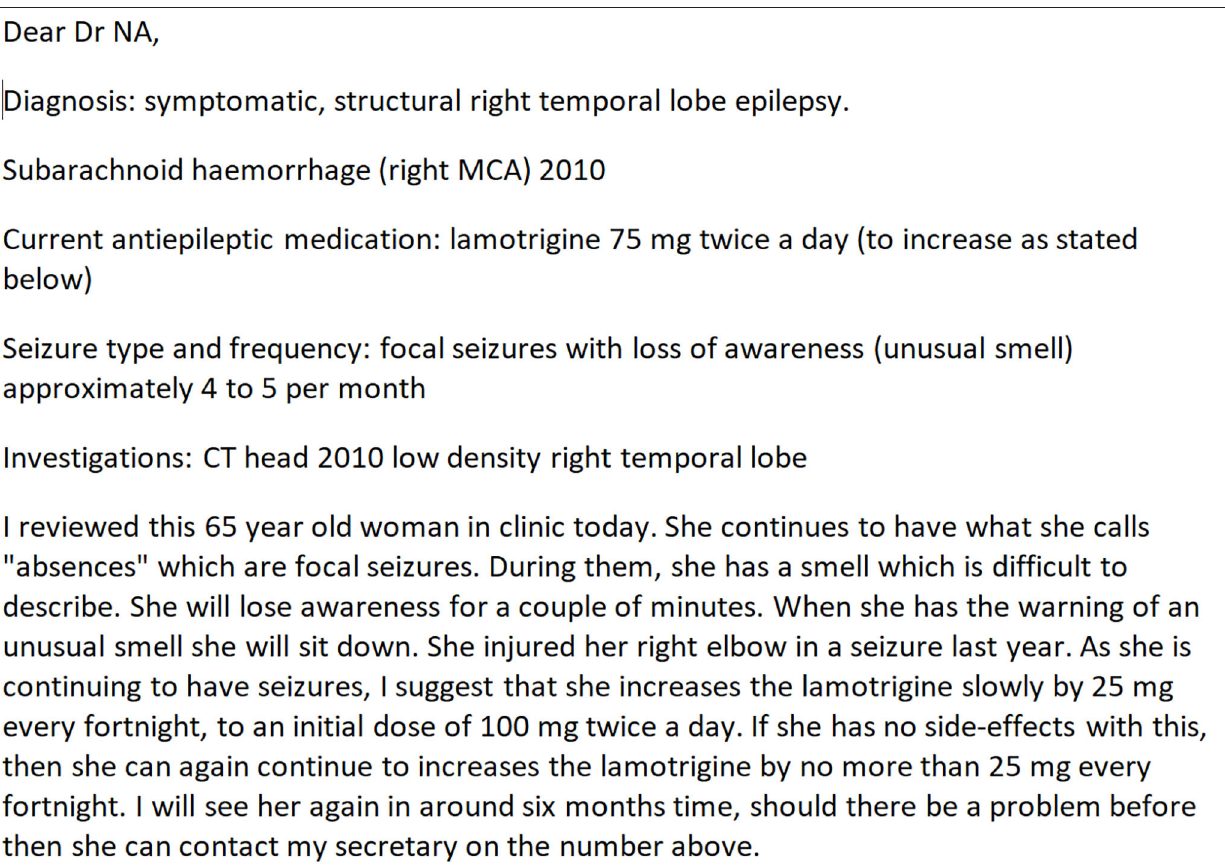
FIGURE 1 | A de-identified and anonymised unstructured free-text clinical